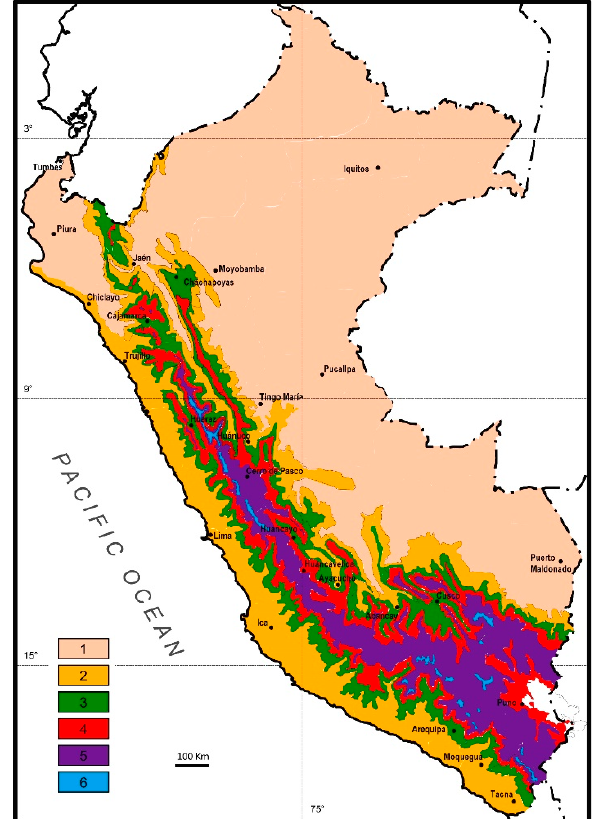
Figure 2. Bioclimatic belts in Peru according to Galán-de-Mera et al. (modified) [40]. 1: Infratropical, 2: Thermotropical, 3: Mesotropical, 4: Supratropical, 5: Orotropical, 6: Cryorotropical.